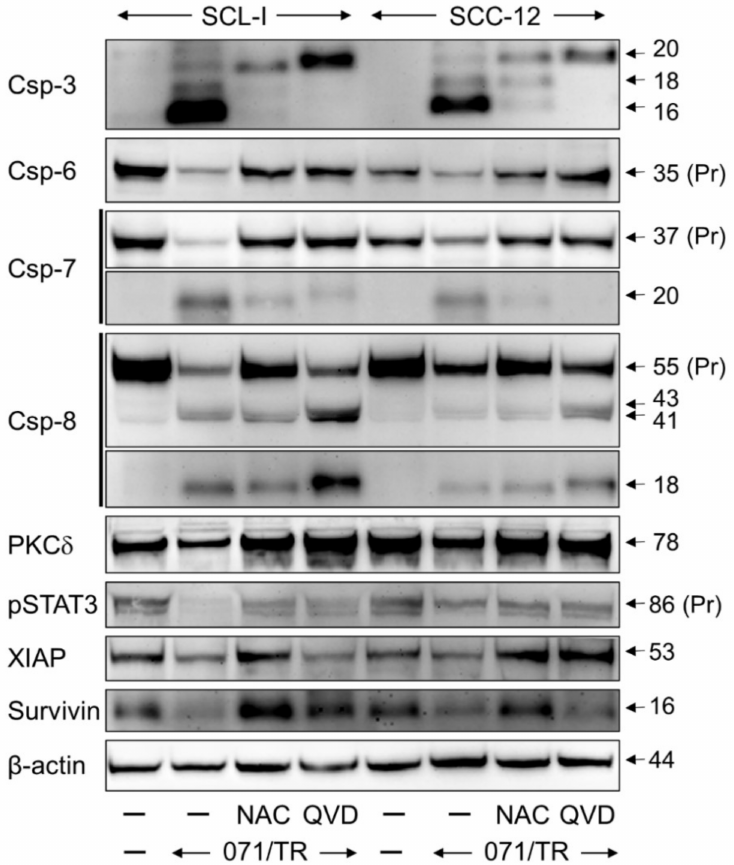
Figure 9. Effects on expression of apoptosis regulators. Expression analysis of characteristic apoptosis regulator proteins in SCL-I and SCC-12 is shown by Western blotting. Cells received pretreatment for 1 h with N-acetylcysteine (NAC, 1 mM) or QVD-Oph (QVD, 10 µ M), followed by combination of DKP-071 (071; 10 µ M) and TRAIL (TR; 50 ng/mL). Proteins had been extracted at 24 h of treatment. Size of proteins (in kDa) is indicated on the right side, as determined in comparison to a protein size marker run in parallel. Expression of β -actin is shown as loading control. Largely similar results were obtained in three independent Western blot experiments using three independent series of cell